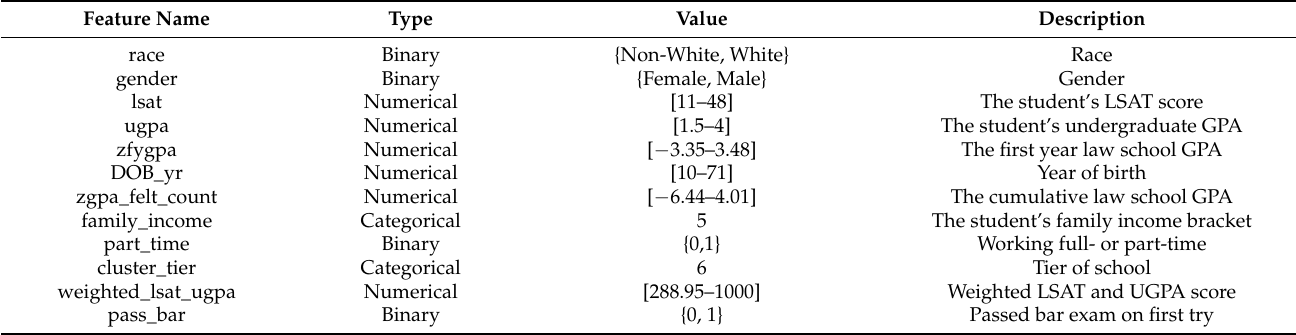
Table A2. LAW data set features adapted from